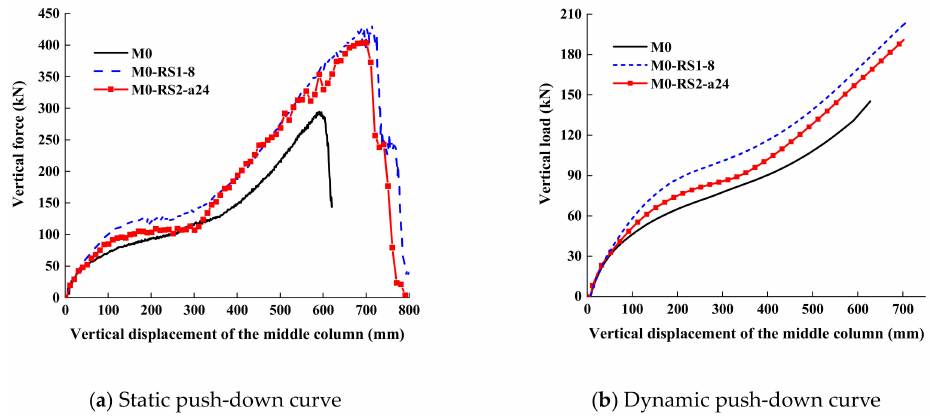
Figure 22. Comparisons between the performance of retrofit strategy 1 and retrofit strategy